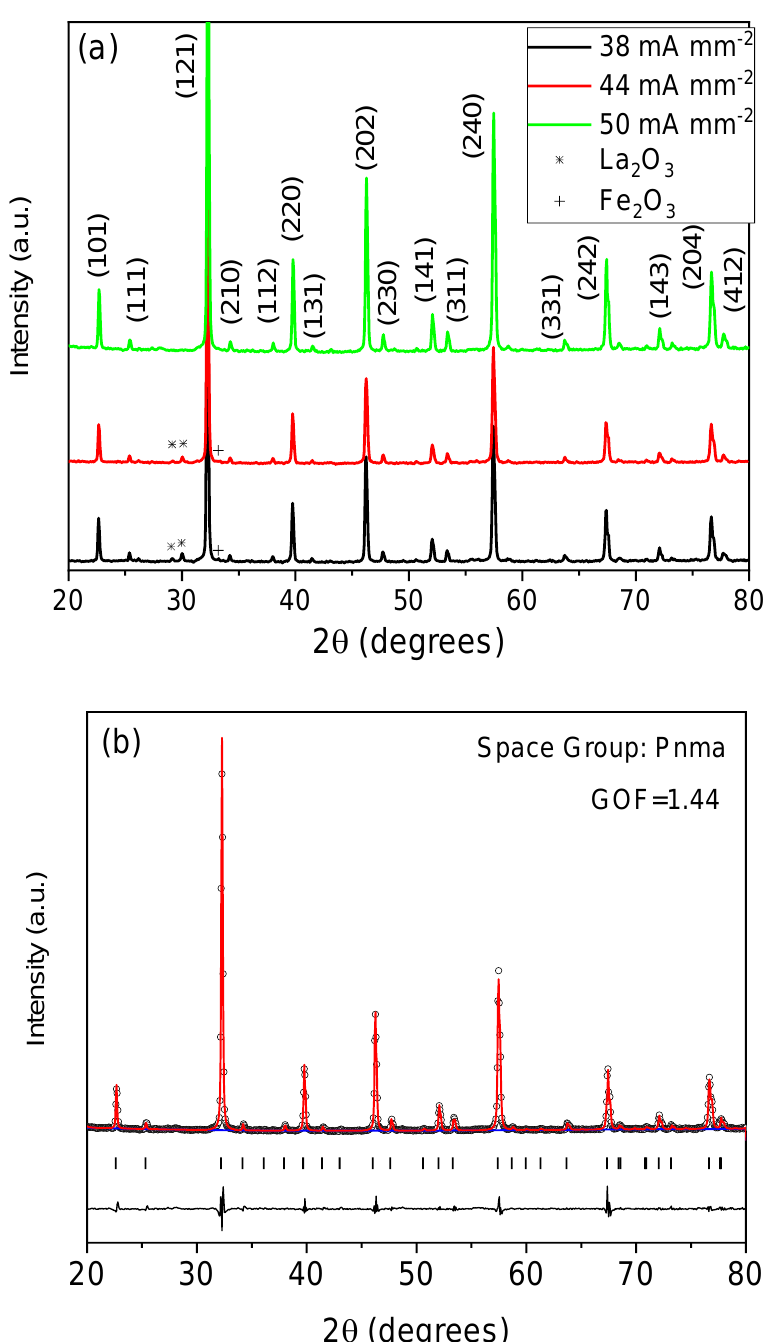
Figure 3. ( a ) XRD patterns of the RFS-ed samples under different current density limits at 1173 K. The indexed peaks correspond to the main diffraction peaks of the LaFeO 3 compound (space group Pnma). The traces of the precursors have been also indicated. ( b ) Le Bail refinement of the XRD pattern corresponding to the phase-pure specimen.